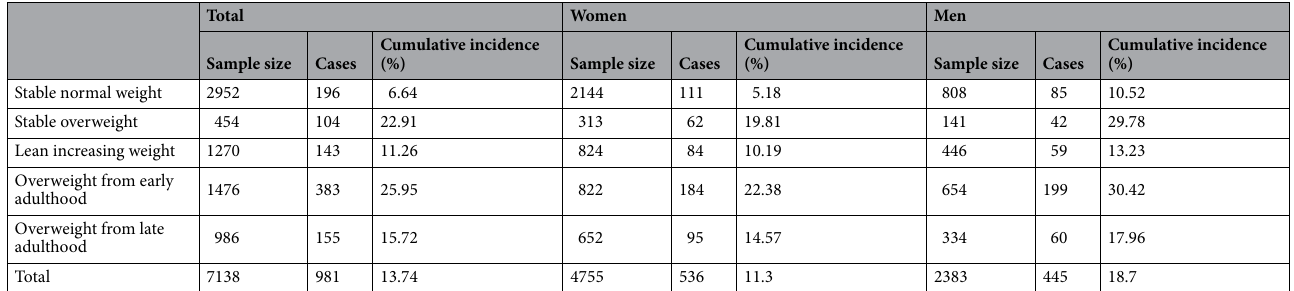
Table 2. Cumulative incidence of type 2 diabetes by sex and life-course trajectories of